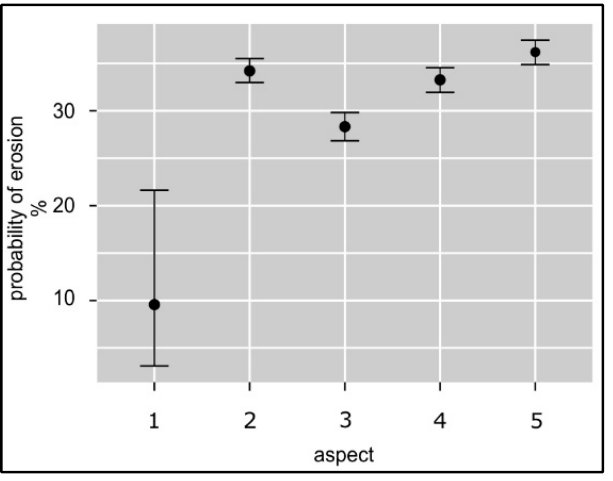
Figure 5. Category of aspect: 1 plane, 2 N, 3 E, 4 S, 5 W. When testing the probability of the occurrence of erosion surfaces in different relief shapes, a higher presence of erosion in convex parts of the slopes was demonstrated. The highest probability was recorded on convex parts of the slopes. Towards the fallen parts of the slopes, the probability of the occurrence of erosion areas decreased linearly (Figure 6). A higher probability was also recorded in the concave-convex parts, which slow down and at the same time disperse the moving material. This confirms that the vertical curvature and convex shapes are of greater importance.